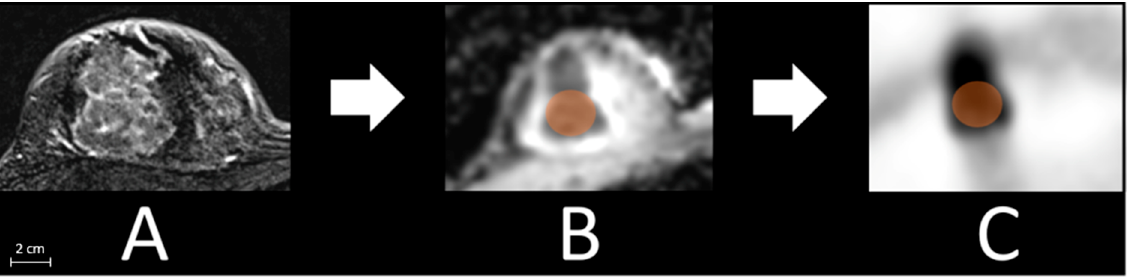
Figure 1. Exemplified measurement processes with detecting the lesion in T1 weighted post-contrast sequence ( A ), pacing a tumor size adapted volume of interest (VOI, orange, 2.3 cm here) in the ADC map ( B ), and afterward copying the VOI to the corresponding slice of the PET images ( C ). Bone marrow: Matching with transverse T1-weighted post-contrast sequence, a bone size adapted VOI (on average 1.0 cm spherical diameter) was placed in the ADC map centrally in each of the following bones: femur right, os sacrum, os ilium right, lumbar vertebral body 5 (L 5), thoracic vertebral body 7 (T 7), and sternum. Afterward, the VOI was copied to the corresponding PET images to match the identical plane and position.